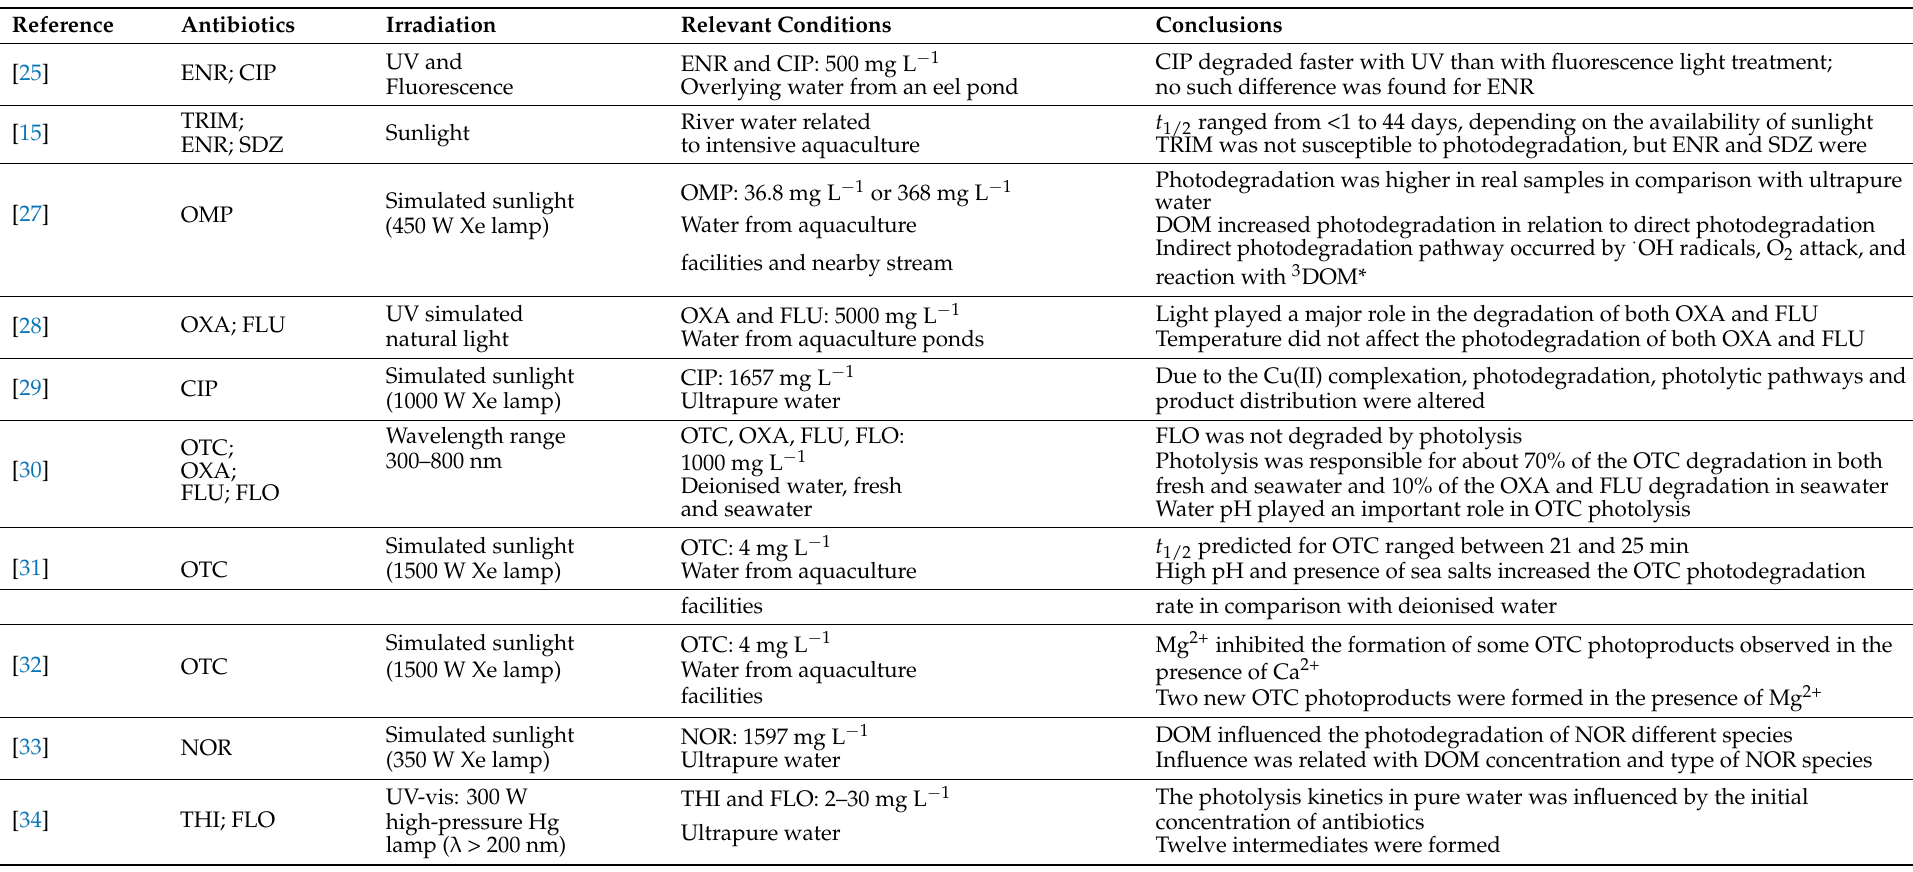
Table 1. Photolysis of antibiotics used in